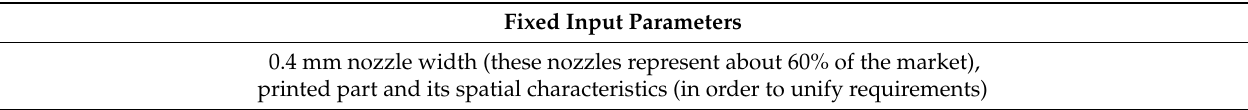
Table 1. Input parameters of the neural